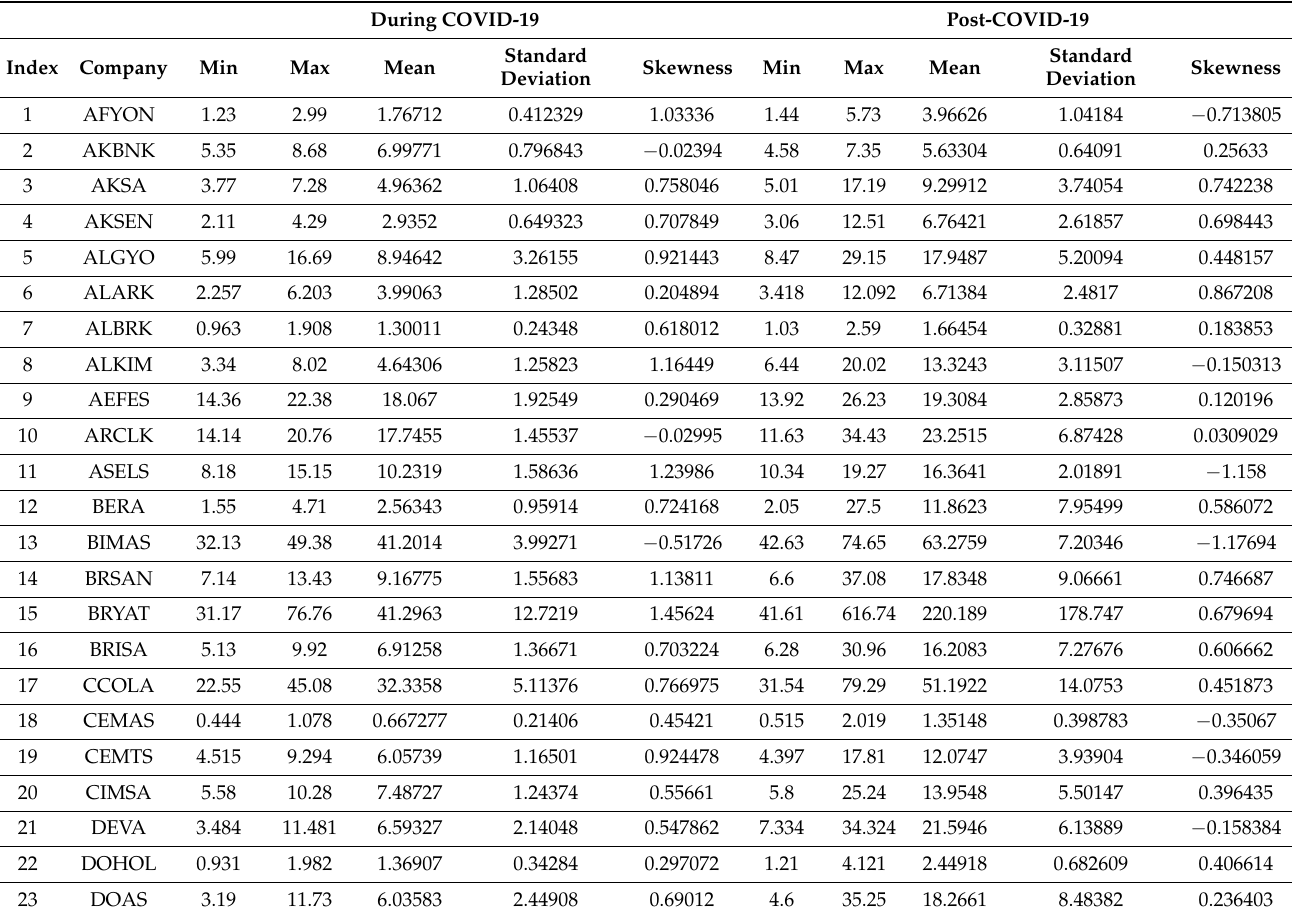
Table A2. Descriptive statistics for the COVID-19 economic period data